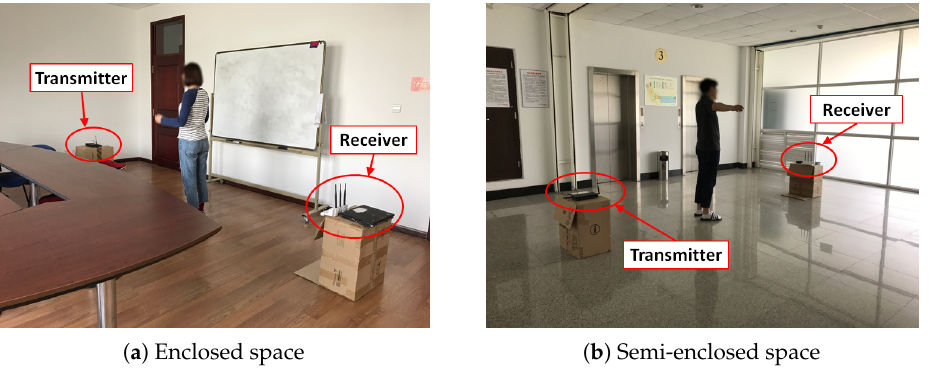
Figure 9. The scenario of human motion detection experiment.